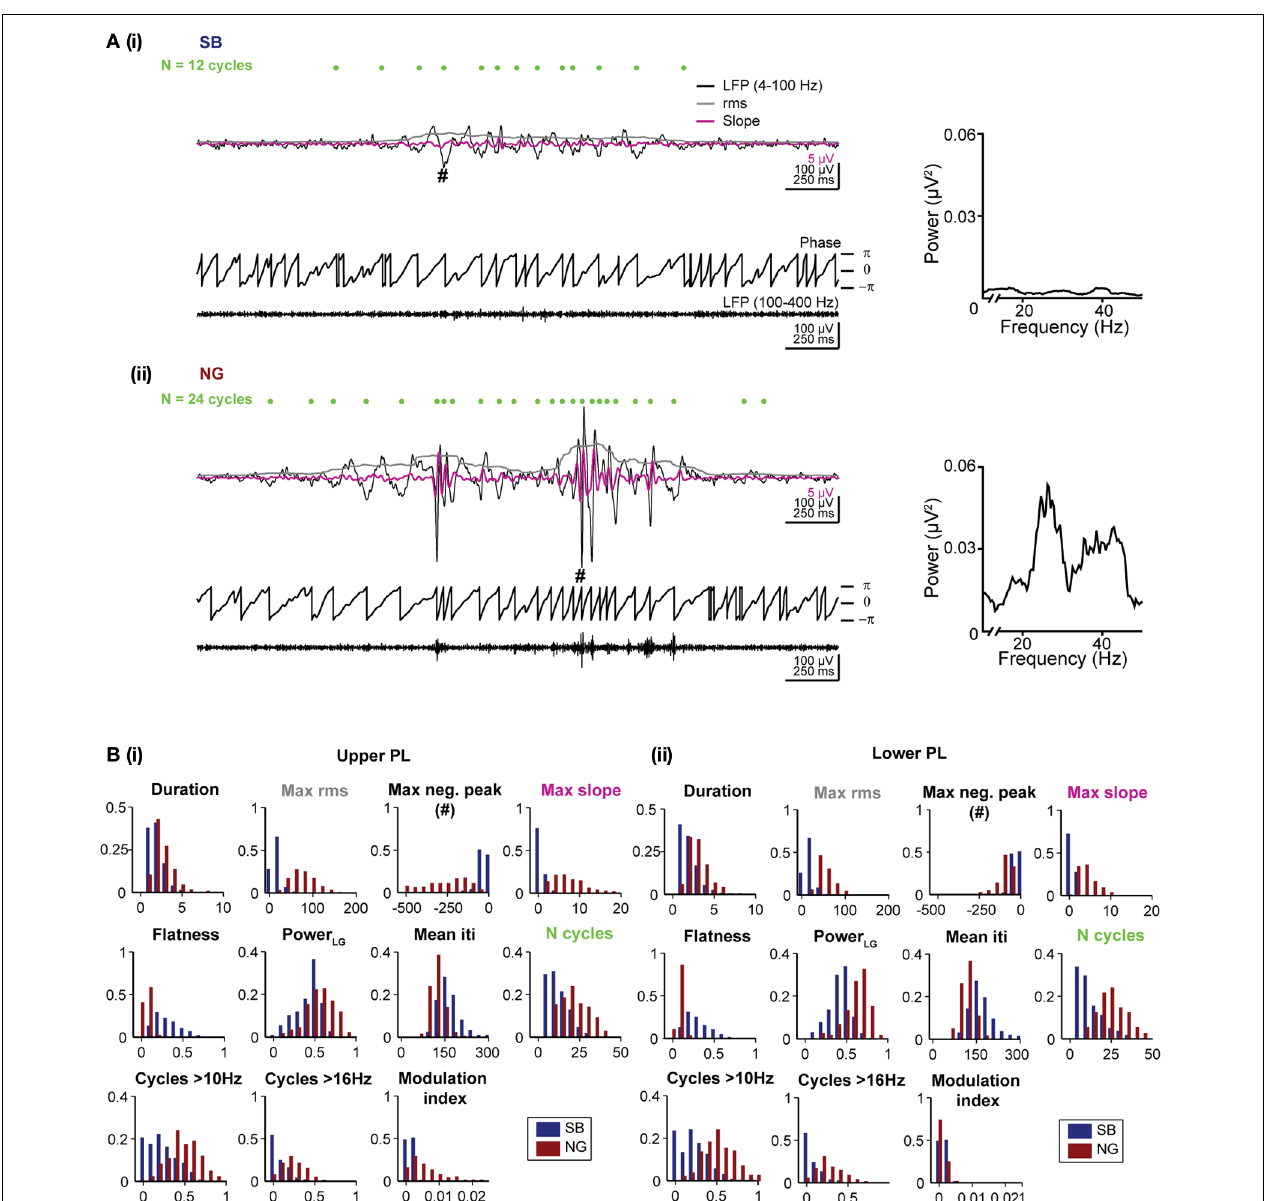
FIGURE 2 | Distinct features of the SB and NG in the PL of neonatal rats. (A) Top, characteristic SB (i) and NG (ii) displayed after band-pass filtering (4–100Hz) accompanied by the rms amplitude (gray trace) and the slope of the signal (magenta trace). Green dots mark the detected troughs of the signal. Bottom, the phase of the filtered (4–100Hz) signal and the signal after